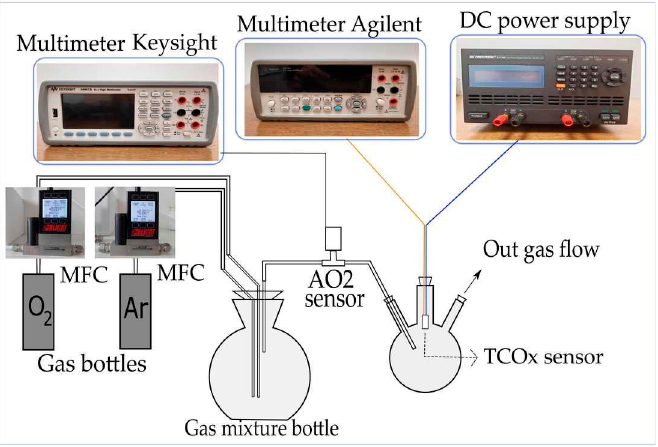
Figure 12. Scheme of the electrical measurements